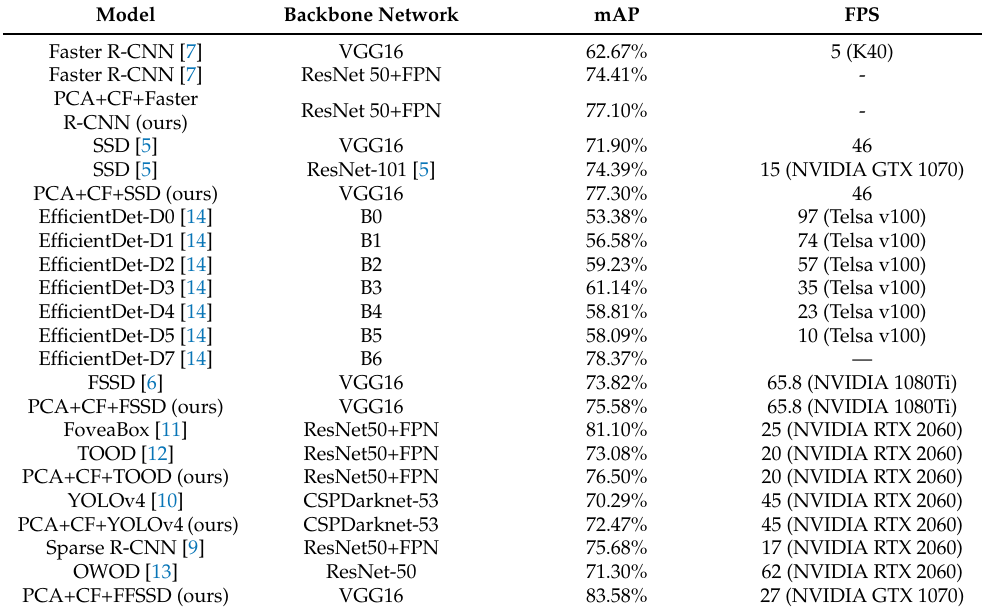
Table 2. Comparison of various